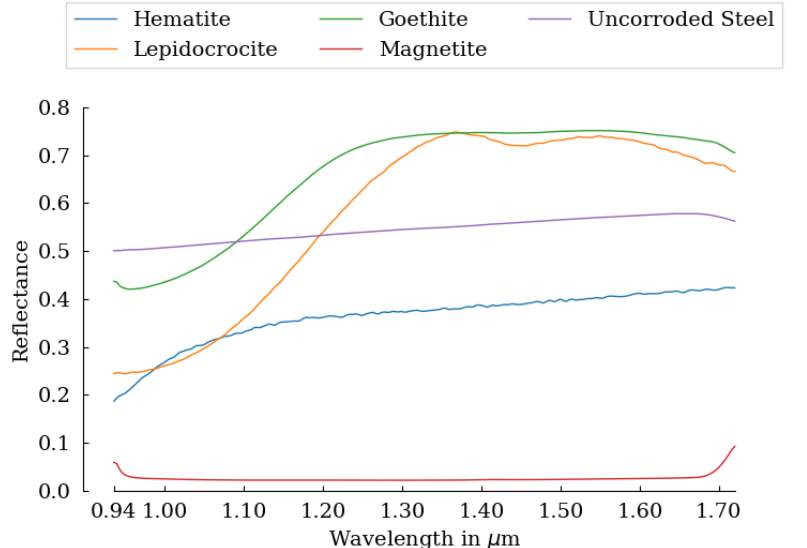
Figure 3. Spectra of the different corrosion minerals found in the USGS spectral library [32]. Uncor- roded Steel is an own measurement before the samples underwent